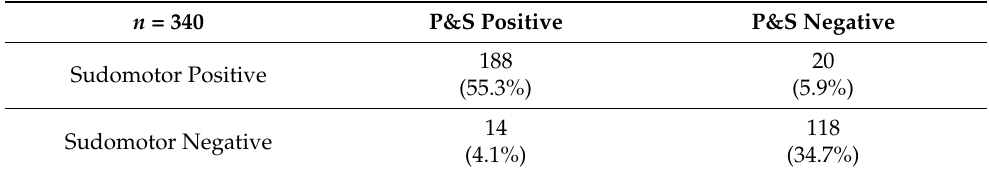
Table 3. Comparison of SFD indications from SweatC™ sudomotor testing (sudomotor) and P&S Monitoring (P&S) considering that the more advanced autonomic neuropathies also involved PAN. In other words, reclassifying patients demonstrating advanced autonomic dysfunction, diabetic autonomic neuropathy or cardiovascular autonomic neuropathy as also demonstrating peripheral autonomic neuropathy and therefore small fiber disorder (P&S Positive). See text for details. n = 340 P&S Positive P&S Negative 188 Sudomotor Positive Sudomotor